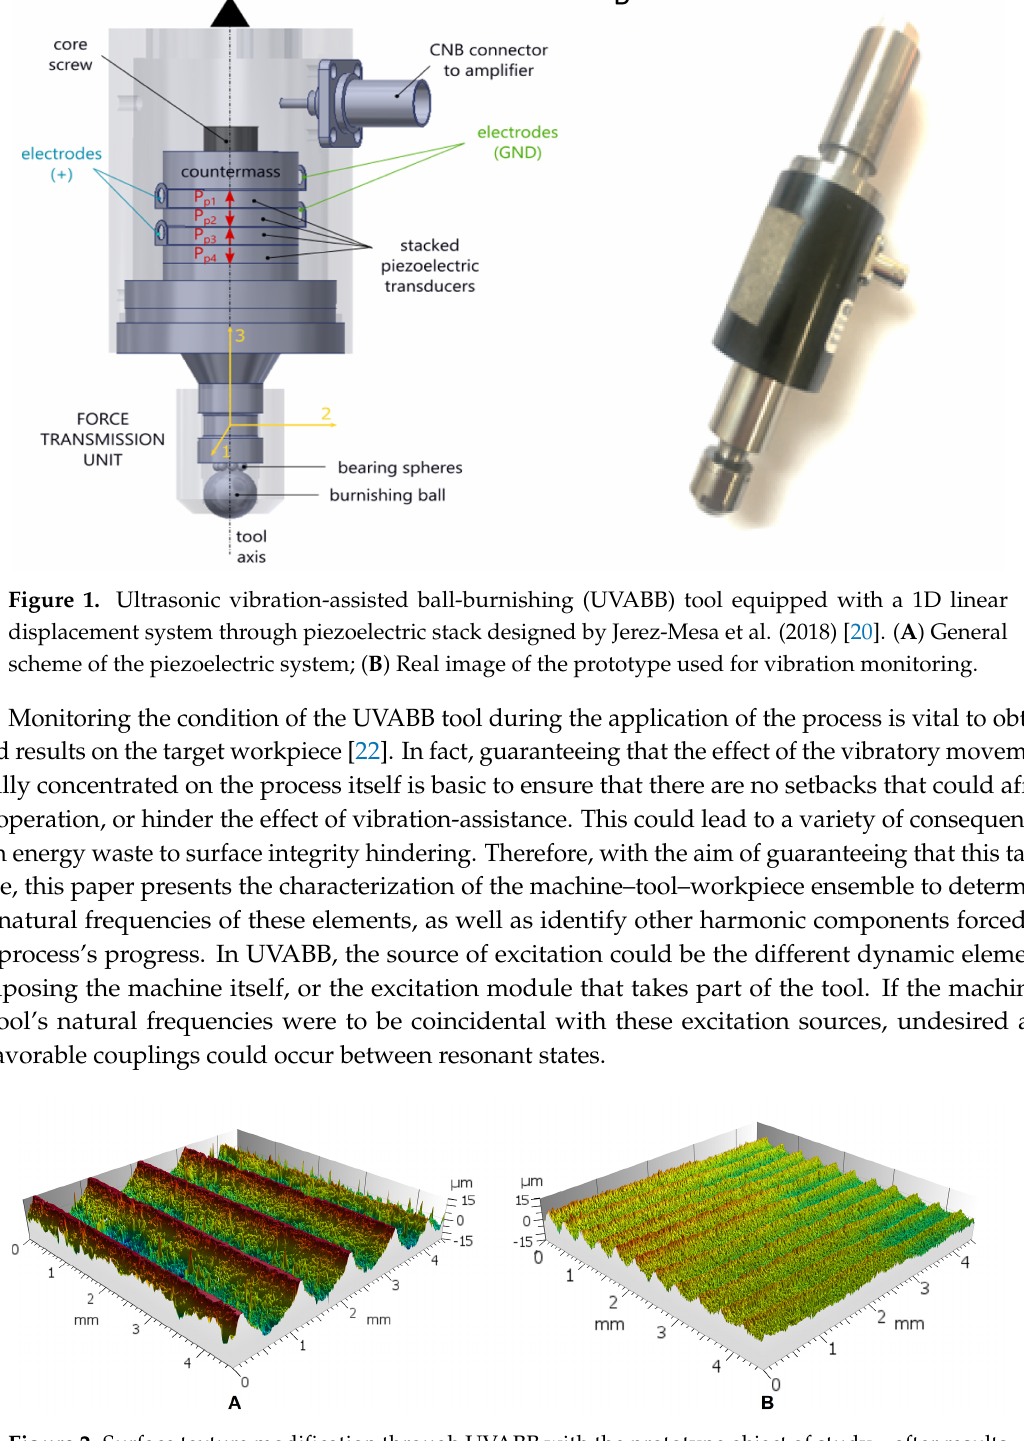
Figure 2. Surface texture modification through UVABB with the prototype object of study—after results obtained previously by Jerez-Mesa et al. (2018). ( A ) Before UVABB; ( B ) After UVABB